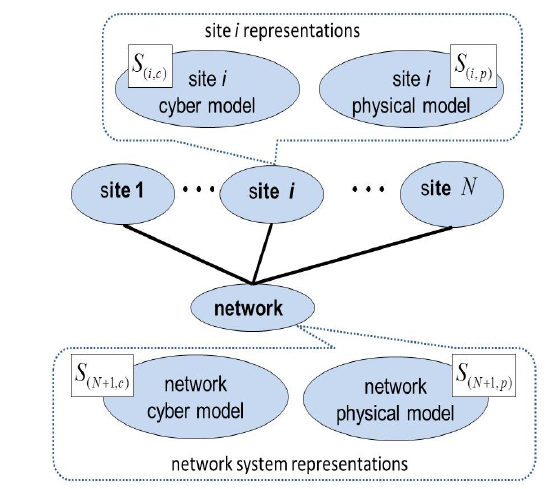
Figure 3. Representation of the cloud computing